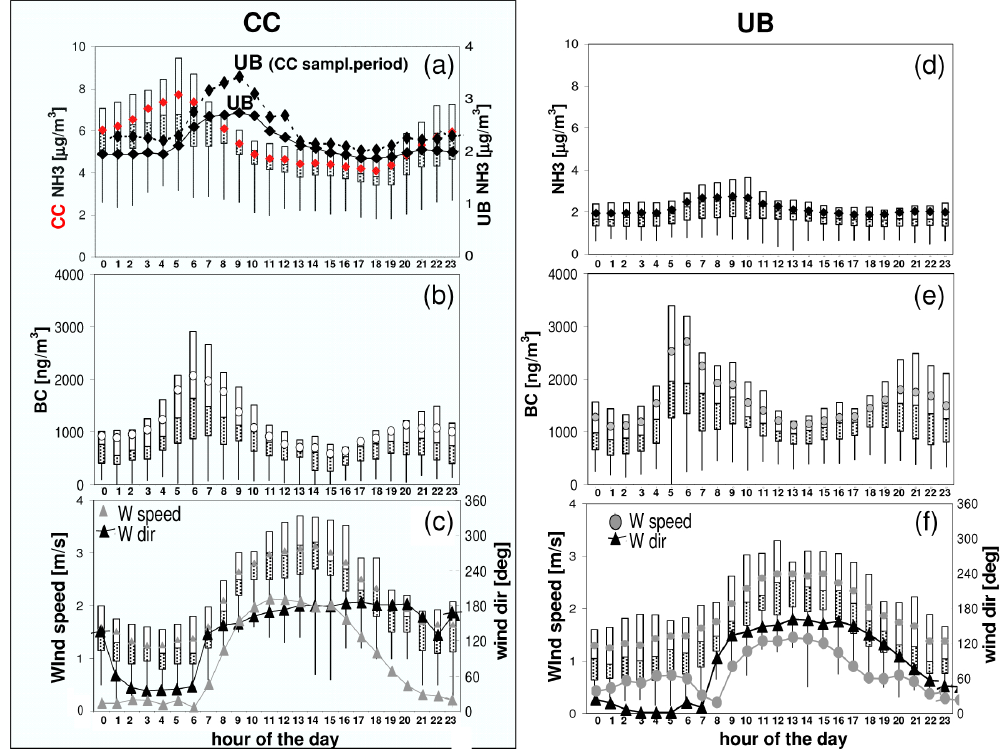
Fig. 5. Daily cycles of: (a) NH 3 concentrations (red dots), (b) black carbon concentrations, and (c) vectorial (grey triangle in the box-and- whiskers plots) and scalar (grey solid line) wind speed and vectorial direction (black triangles) measured at CC over the period 13 May– 28 June; and daily cycles of: (d) NH 3 concentrations, (e) BC concentrations, (f) wind speed (scalar and vectorial) and direction (vectorial) measured at UB over the period 6 May–7 September. In Fig. 5a the concentrations of NH 3 measured at UB over the periods 6 May– 7 September (black solid line) and 13 May–28 June (black dashed line) are also reported. Box-and whiskers plots represent the 25th and 50th percentiles (upper white and lower grey boxes), colored symbols represent the means, the black horizontal bands represent the median (50th percentiles) and lower error bars represent the minimum measured